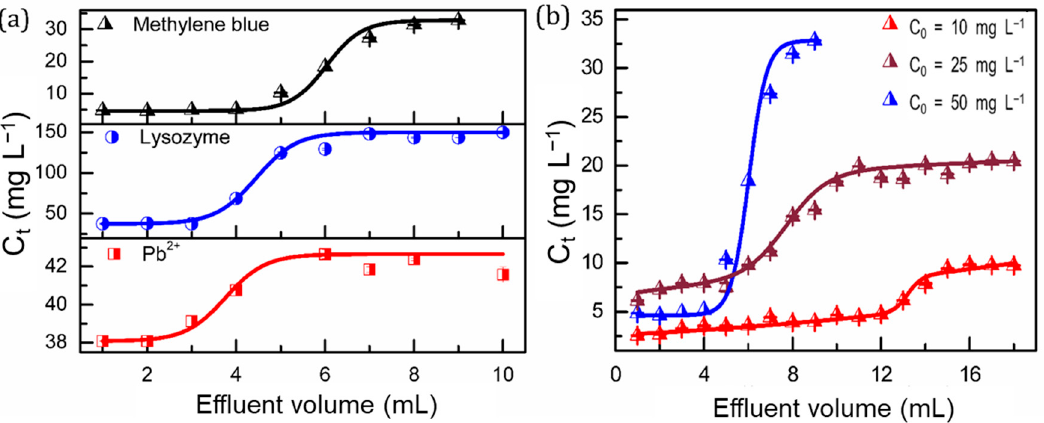
Figure 6. ( a ) Breakthrough curves for the penetration of the pollutants through the SPS foams and ( b ) dependence of breakthrough curves on the initial concentration of MB.